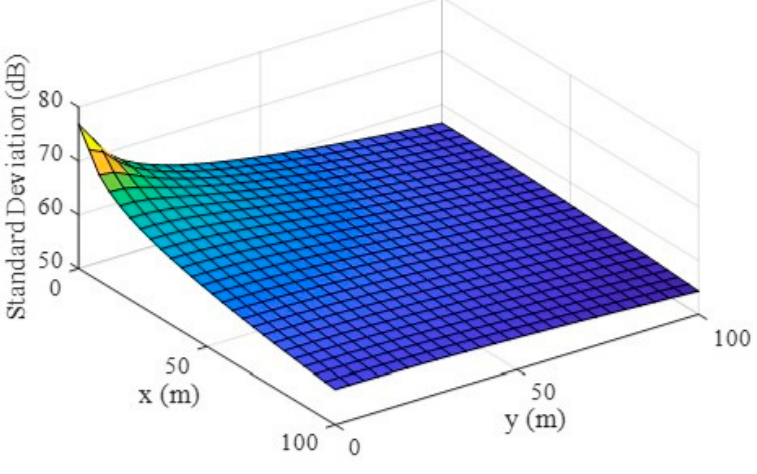
Figure 8. Standard deviation of energy response of the membrane with a random length in space field. The reference energy is 10 − 12 J/m 2 .